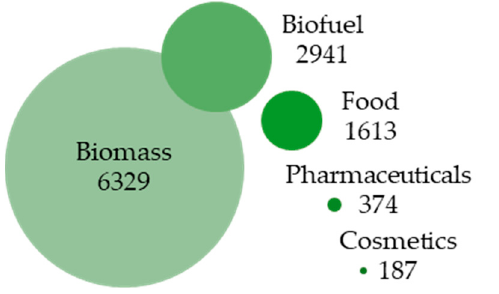
Figure 1. Research areas of publications associated with the term “microalgae“. Bubbles show the number of results of combined searches “microalgae + indicated term” based on publications of the past five years [Source: webofknowledge.com].